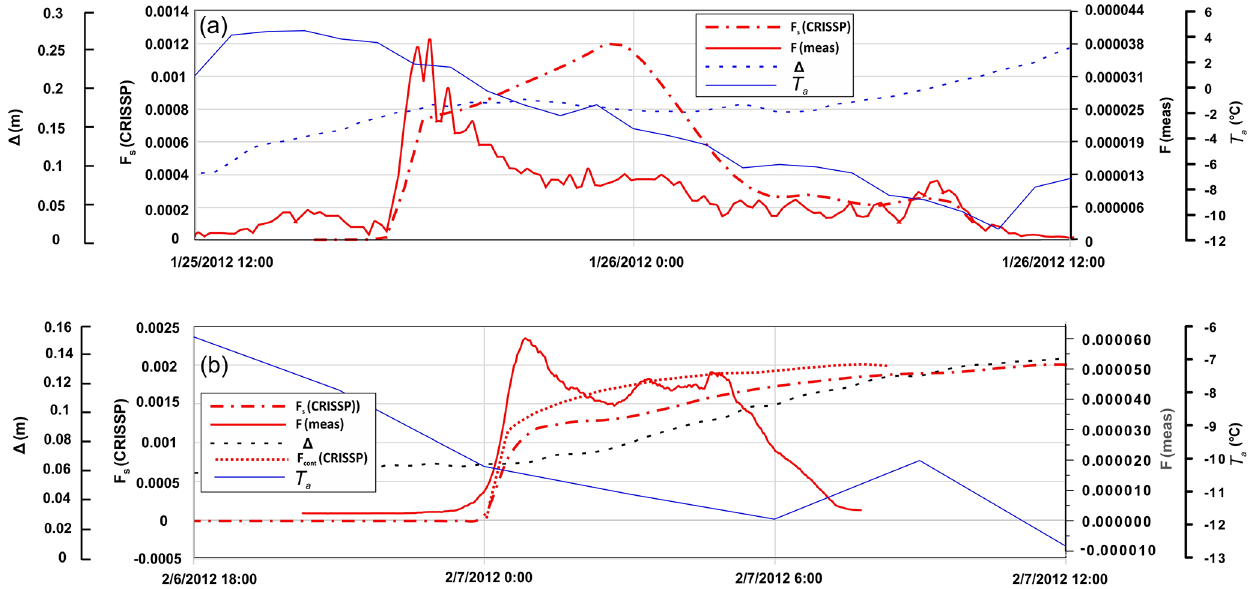
Figure 2. Comparisons of fractional volumes as measured ( F (meas)) and simulated ( F s (CRISSP), F cont (CRISSP)) and T a for (a) interval 4 and (b) interval 5. The F s (CRISSP) simulations were shifted to earlier and later times by 11.0 and 3.5h, respectively, to facilitate coincidence with observed frazil onsets. The plot in panel (b) includes F cont (CRISSP) depicting an artificially triggered simulation described in the text which uses fully contemporary post-onset environmental inputs. The measured and simulated fractional volumes were representative of, respectively, measurements 2.3m above the SWIPS instrument and water column mean values. An additional, dotted, curve in panel (b) represents (cid:49) , the difference between 10-point-averaged measured water levels and those simulated by CRISSP1D without allowances for anchor ice. Model air temperature inputs, T a , are plotted in both figures.